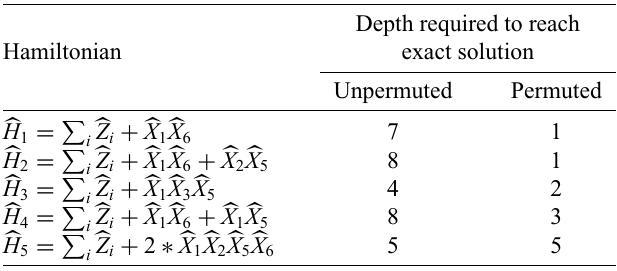
TABLE I. Ansatz depth for six-qubit Ising models. For various Ising models, the ansatz depth that is required to reach the exact energy is shown for the unpermuted case and for the optimally permuted